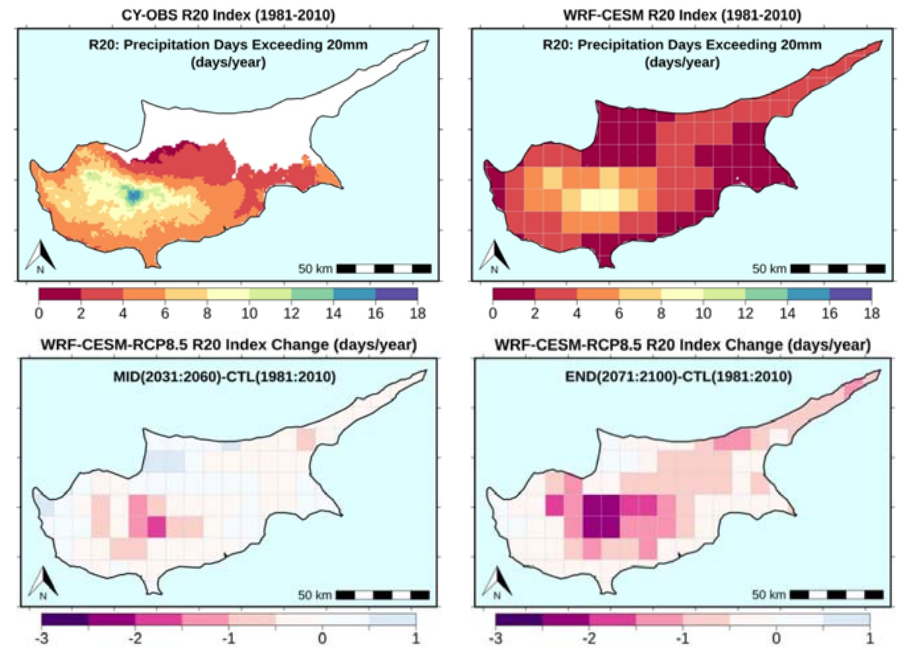
Figure 10. Observed ( top left ) and simulated ( top right ) number of heavy precipitation days per year (R20) for the period 1981 to 2010 and projected changes for the middle ( bottom left ) and end of the 21st century ( bottom right ).